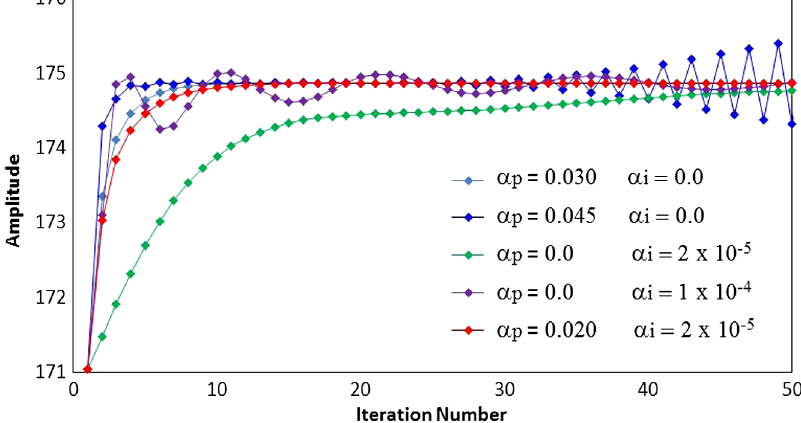
FIG. 10. Convergence of pulse amplitude as a function iteration number at time 142.5 ns after the start of the pulse for differing controller coefficients.